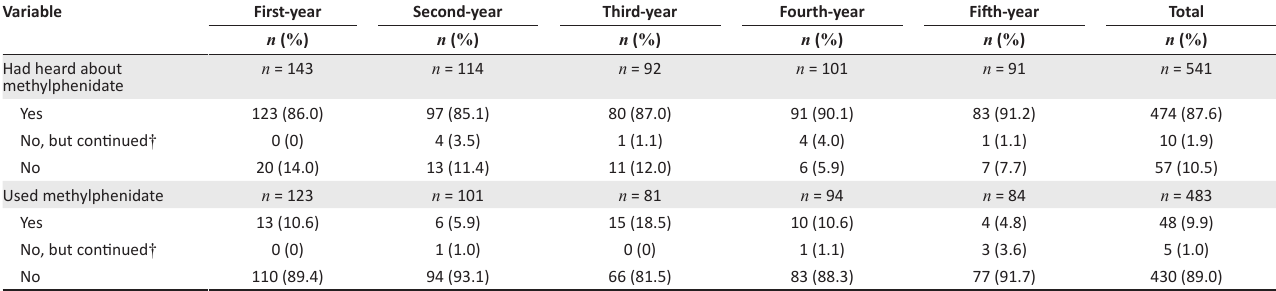
TABLE 1: Percentage of students across year groups and overall who had heard about methylphenidate and had used this stimulant.